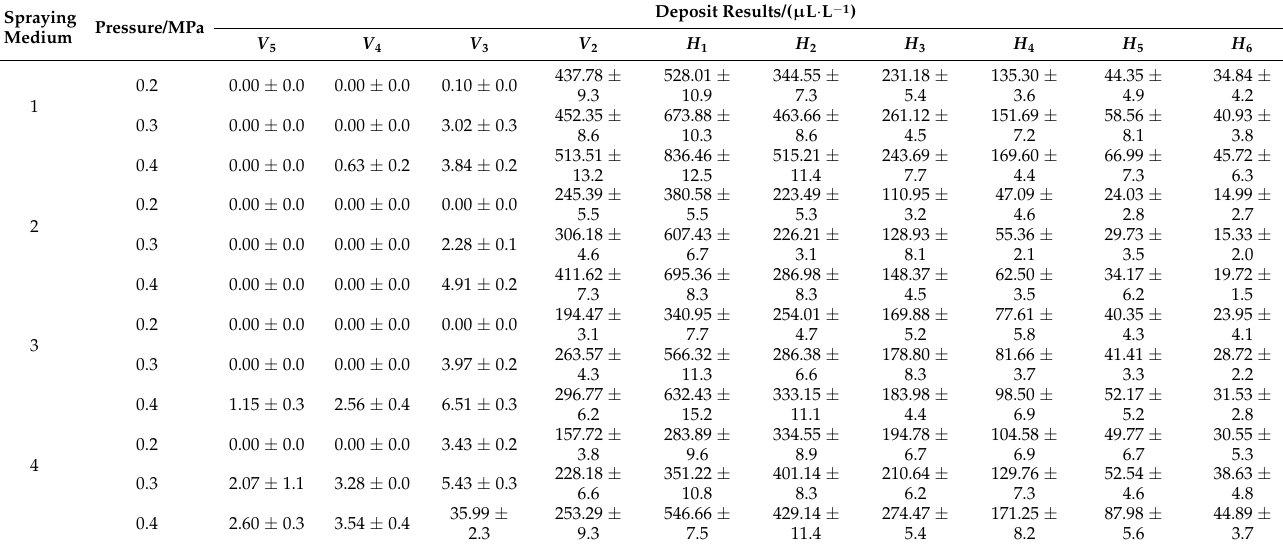
Table 3. Deposition distribution under different spray conditions along vertical and horizontal